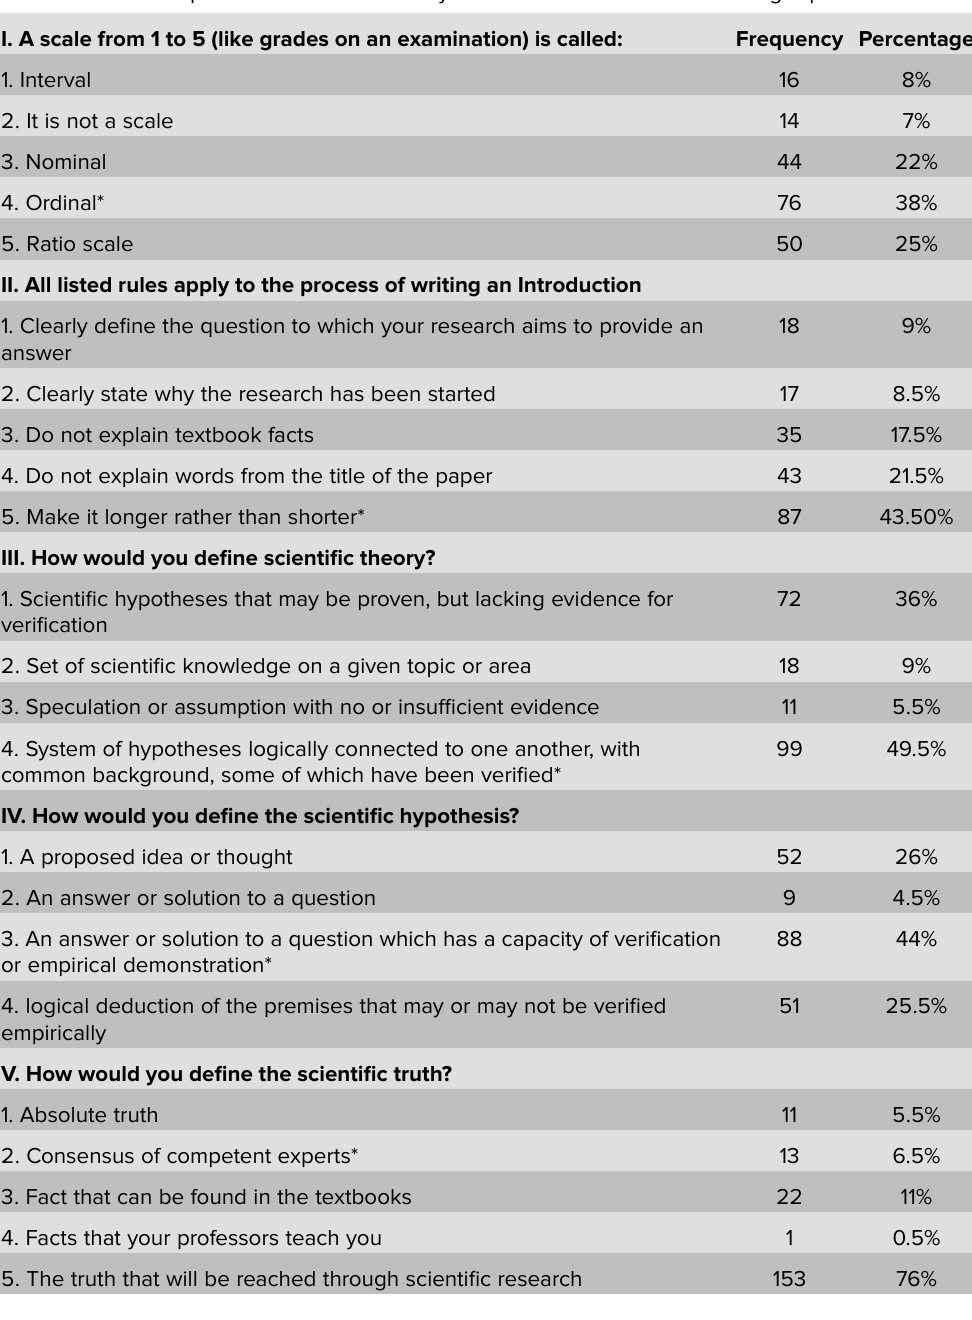
TABLE 1: Responses of fifth- and sixth-year medical students to knowledge